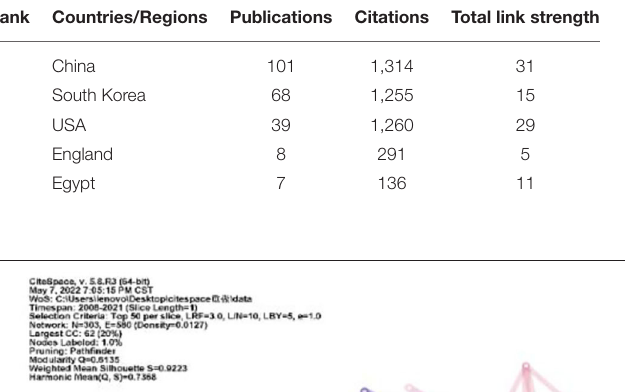
Frontiers in Neurology |